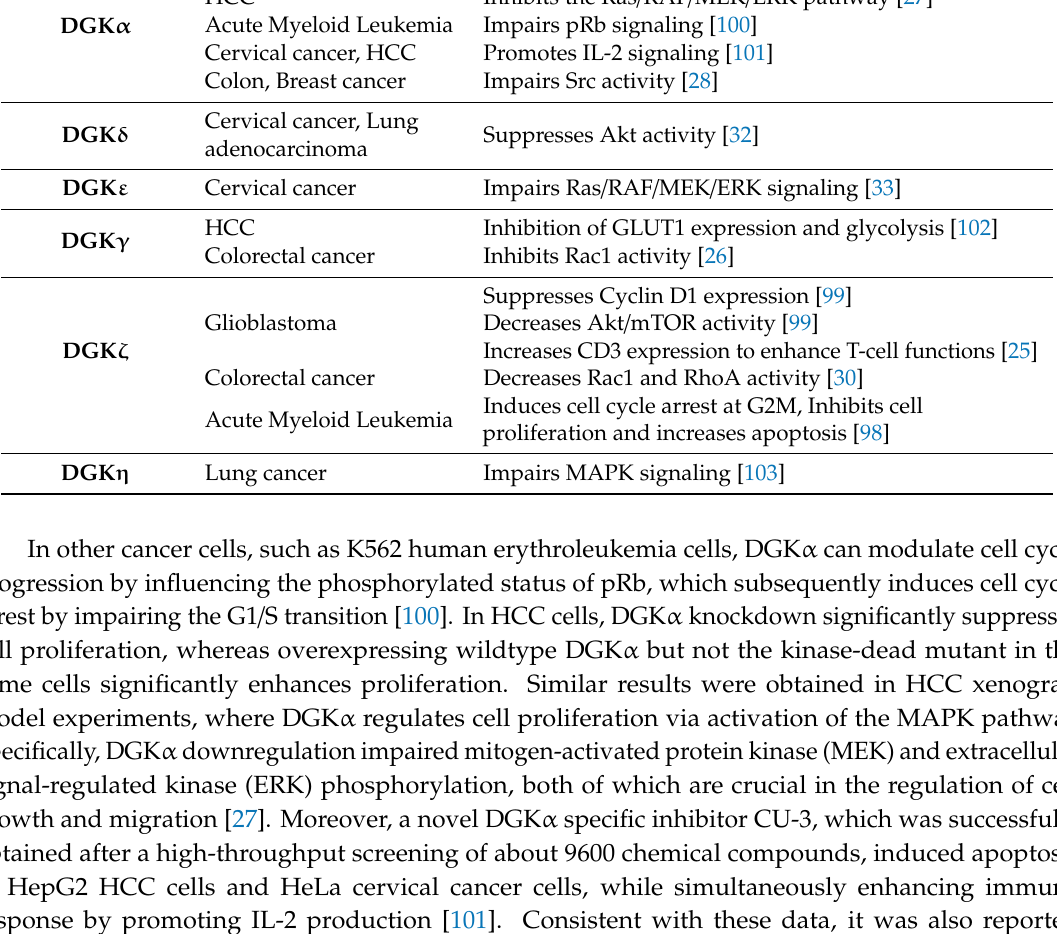
Table 2. Functional e ff ects on cancer upon the downregulation of DGKs. DGK Isoform Cancer Type E ff ects Caused by Downregulating DGKs Glioblastoma Decreases Akt / mTOR, HIF1 α , c-Myc activity [29] HCC Inhibits the Ras / RAF / MEK / ERK pathway [27] Acute Myeloid Leukemia Impairs pRb signaling [100] DGK α Cervical cancer, HCC Promotes IL-2 signaling [101] Colon, Breast cancer Impairs Src activity [28] Cervical cancer, Lung DGK δ Suppresses Akt activity [32] adenocarcinoma DGK ε Cervical cancer Impairs Ras / RAF / MEK / ERK signaling [33] HCC Inhibition of GLUT1 expression and glycolysis [102] DGK γ Colorectal cancer Inhibits Rac1 activity [26] Suppresses Cyclin D1 expression [99] Glioblastoma Decreases Akt / mTOR activity [99] Increases CD3 expression to enhance T-cell functions [25] DGK ζ Colorectal cancer Decreases Rac1 and RhoA activity [30] Induces cell cycle arrest at G2M, Inhibits cell Acute Myeloid Leukemia proliferation and increases apoptosis [98] DGK η Lung cancer Impairs MAPK signaling